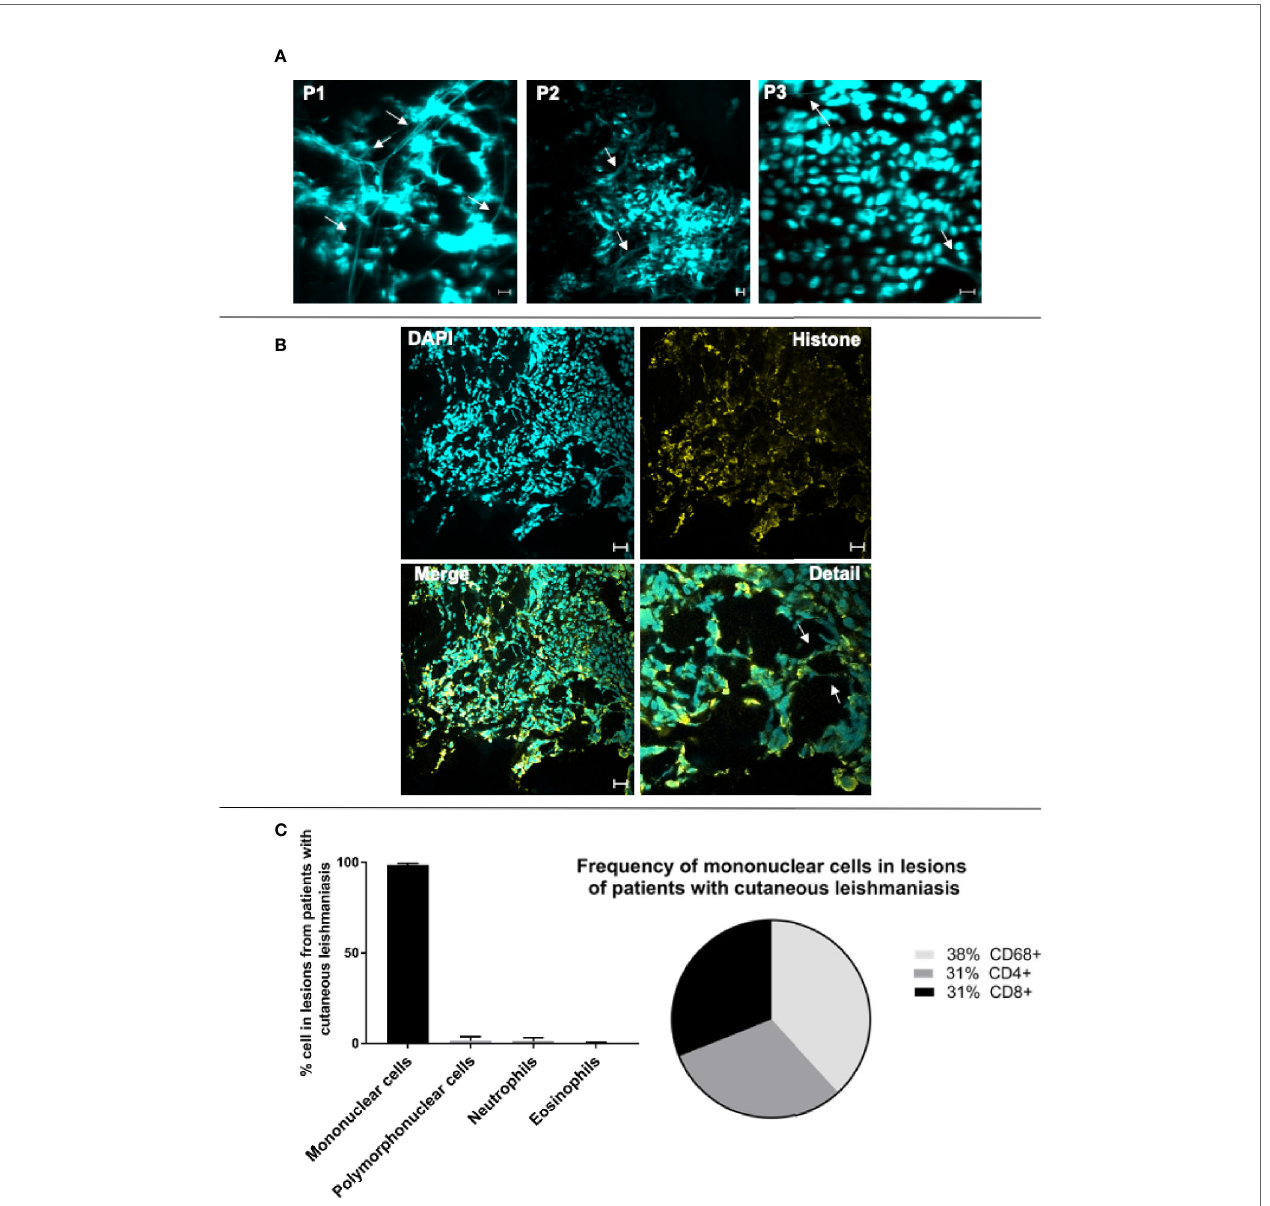
FIGURE 7 | Lesions of patients with cutaneous leishmaniasis display extracellular DNA. Tissue sections were stained with DAPI or Alexa 488-labeled anti-histone monoclonal antibodies as described in Materials and Methods . (A) Representative confocal images of lesions from patients with cutaneous leishmaniasis stained with DAPI alone (P1, P2 and P3 represent three different patients), showing the occurrence of extracellular DNA structures. The bars = 10 m m. (B) Representative lesion from a cutaneous leishmaniasis patient stained with DAPI and anti-histone monoclonal antibody. In detail, colocalization of the DAPI (light blue) and histone (yellow). Arrows show extracellular DNA co-stained with DAPI and anti-histone monoclonal antibody. Bars = 20 m m. (C) Evaluation of cellular composition of lesions from cutaneous leishmaniasis patients (n=14) through histopathology analysis using hematoxylin/eosin stain (graph), and confocal microscopy using anti-CD4, anti-CD8 and anti-CD68 monoclonal antibodies (pie chart), as described in Materials and Methods